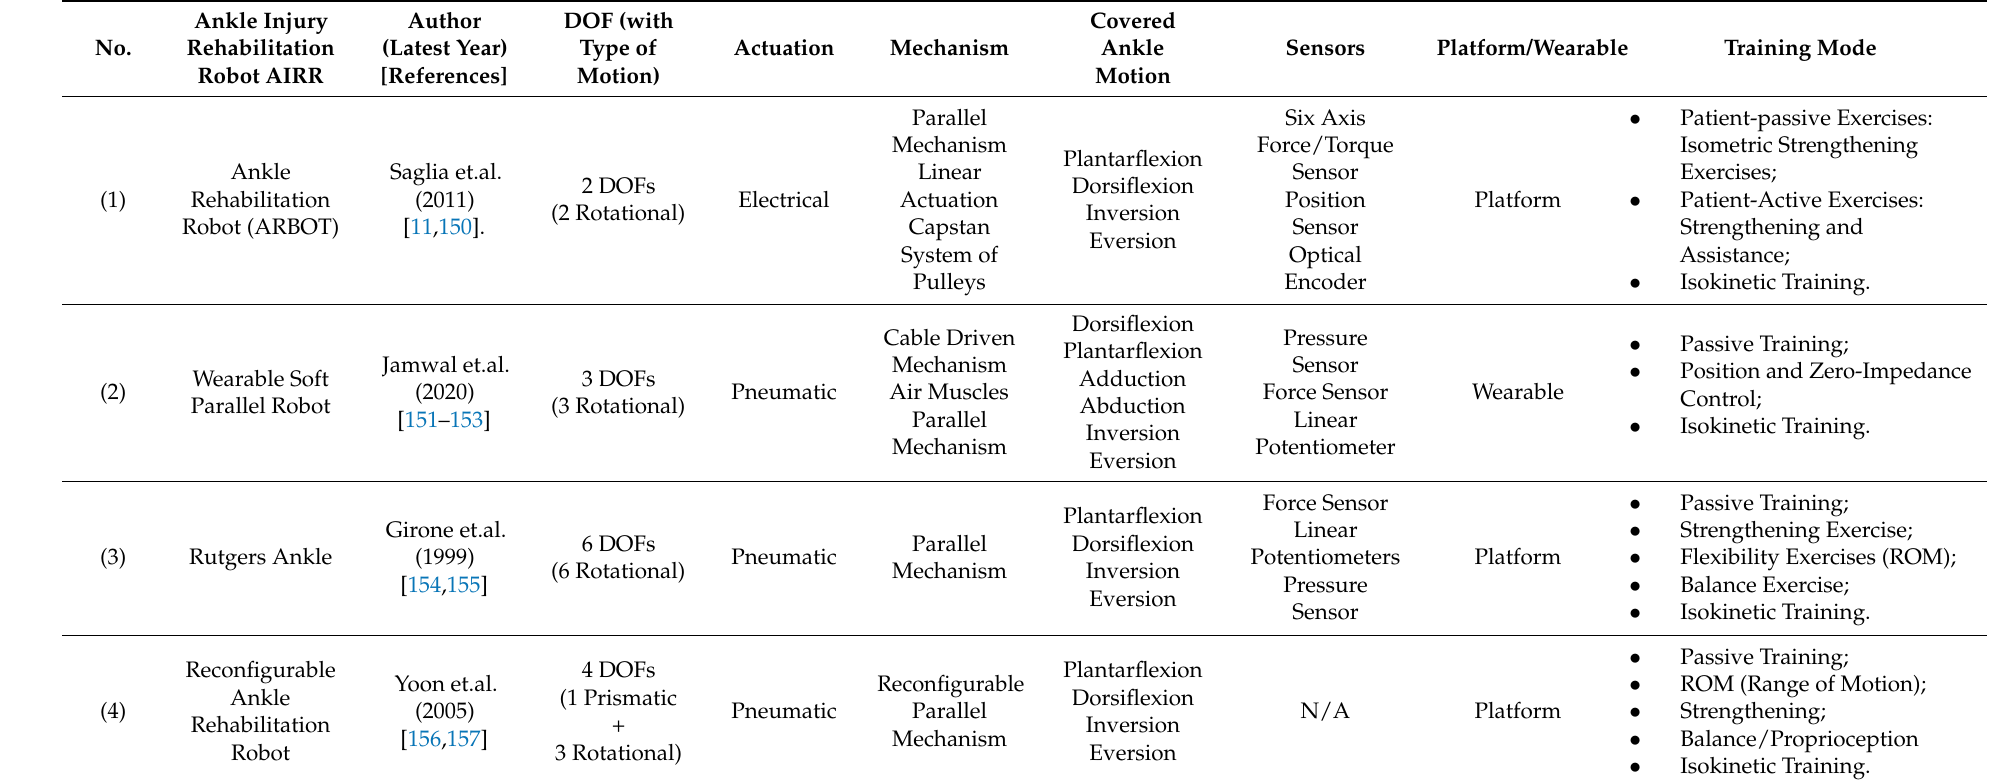
Table 1. Summary comparative table on the ankle injury rehabilitation robots